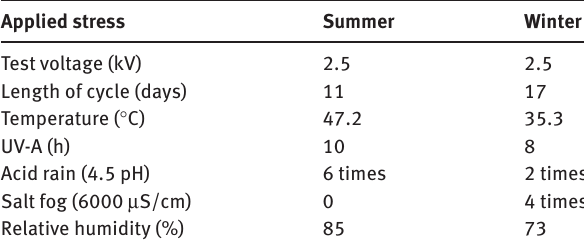
Table 2: Summer and winter weather cycles. Applied stress